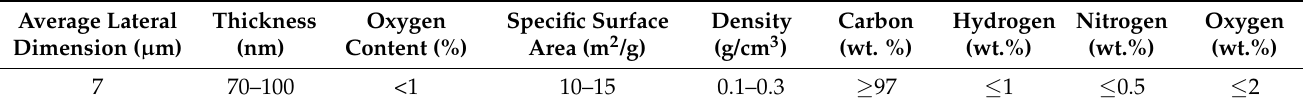
Table 1. Characteristics of the nanographene